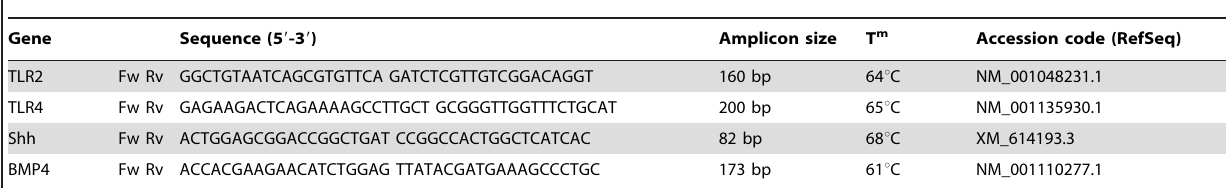
Table 1. Primers used for